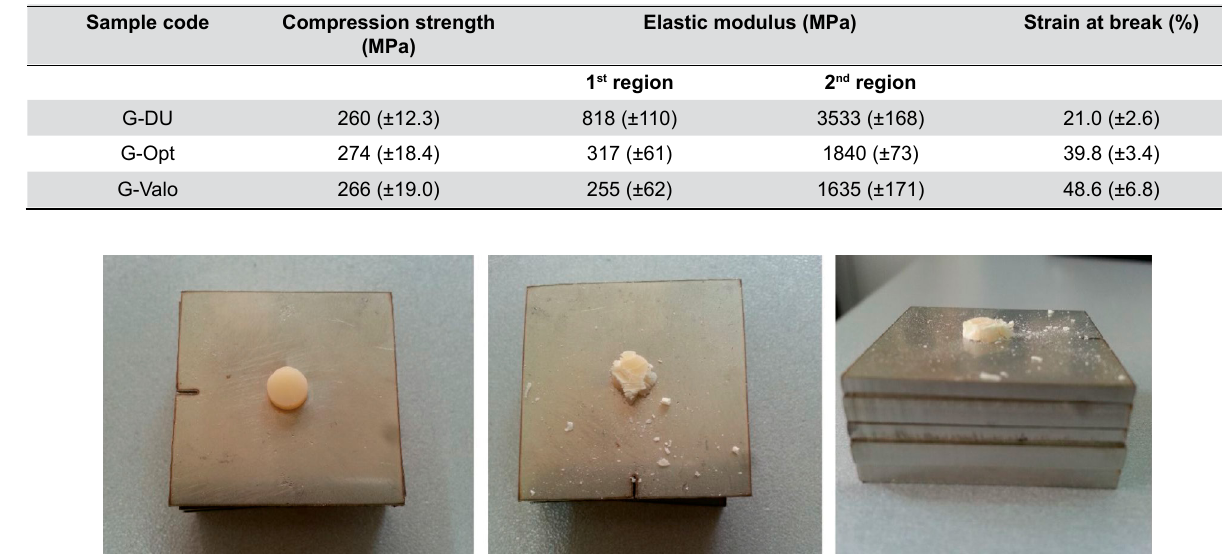
as “elastic (or compressive) modulus”, which is a